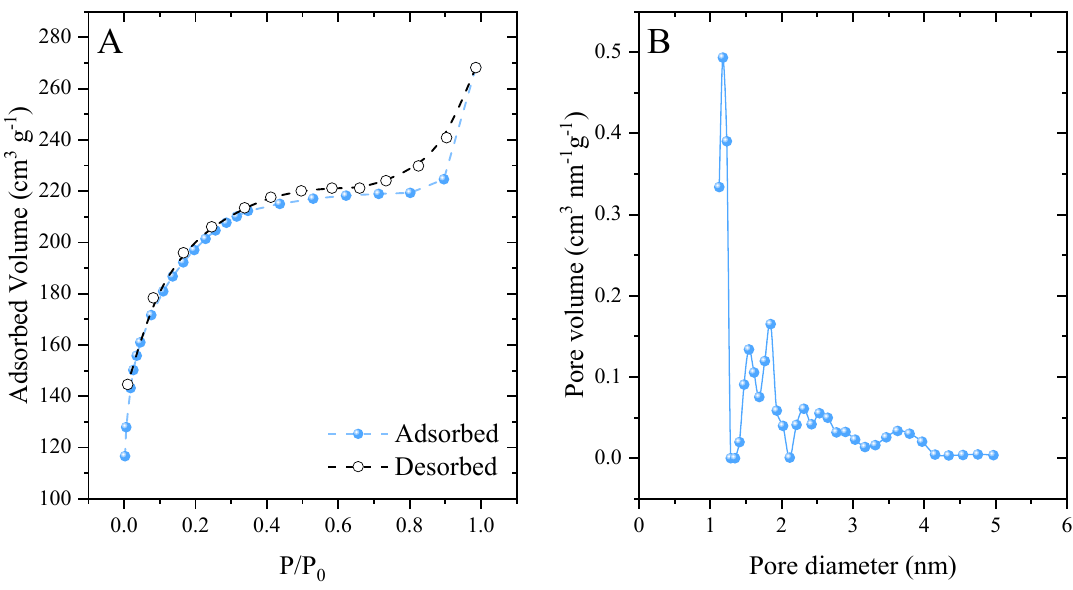
Molecules 2022 , 27 , x FOR PEER REVIEW